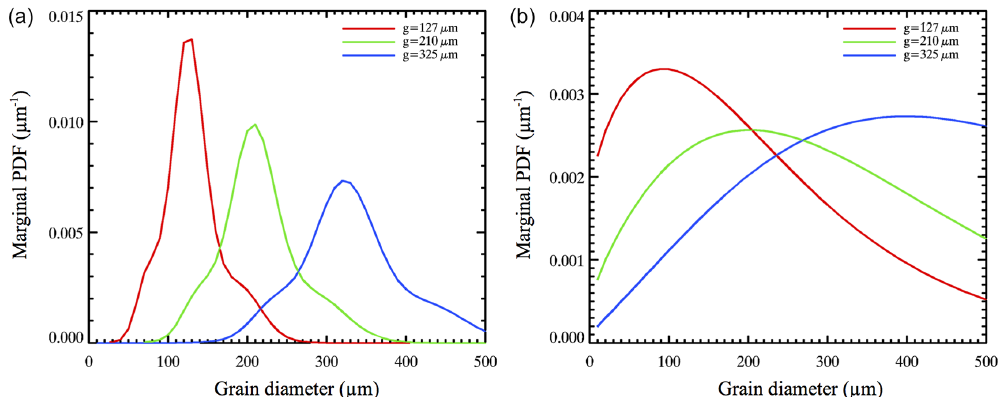
Figure 4. Normalized stacks of 1000 a posteriori PDFs for the grain diameter of the snow, when conducting the inversion on synthetic data, with added random noise. The legends indicate the values for the grain diameter used to create the synthetic data. (a) The ice layer is 1mm thick. (b) The ice layer is 5mm thick.